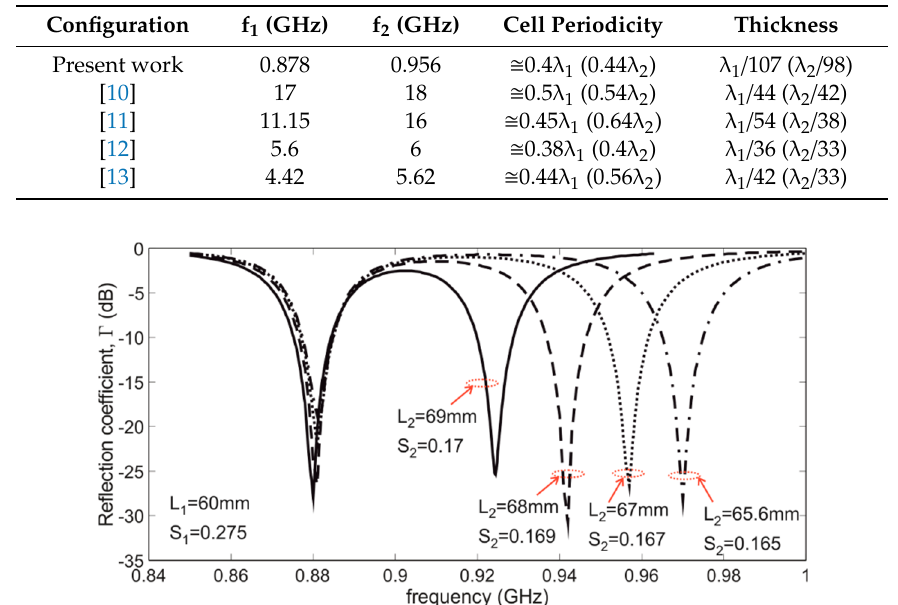
Figure 4. Reflection coefficient vs. frequency of the synthesized dual-band metamaterial absorber (MA) cell for different incidence angles ( ε r = 4.2, tan δ = 0.015 and h = 3.2 mm–D ≅ 0.4 λ @ f 1 ): ( a ) TE-polarization ( b ) TM-polarization. Table 1. Comparison with previously proposed dual-band MAs. Table 1. Comparison with previously proposed dual-band MAs.